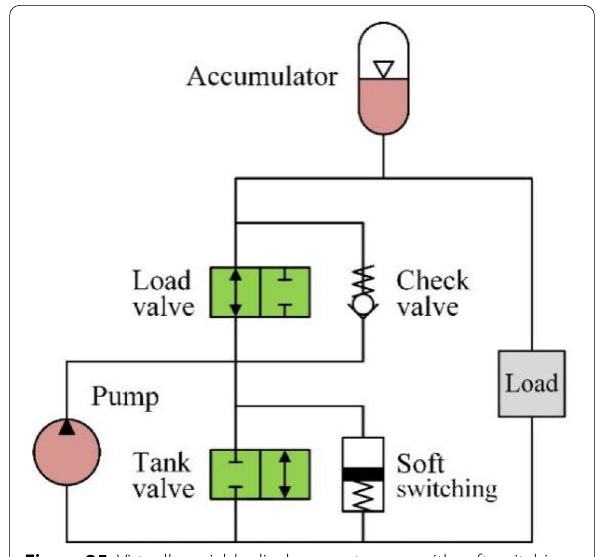
Figure 25 Virtually variable displacement pump with soft switching